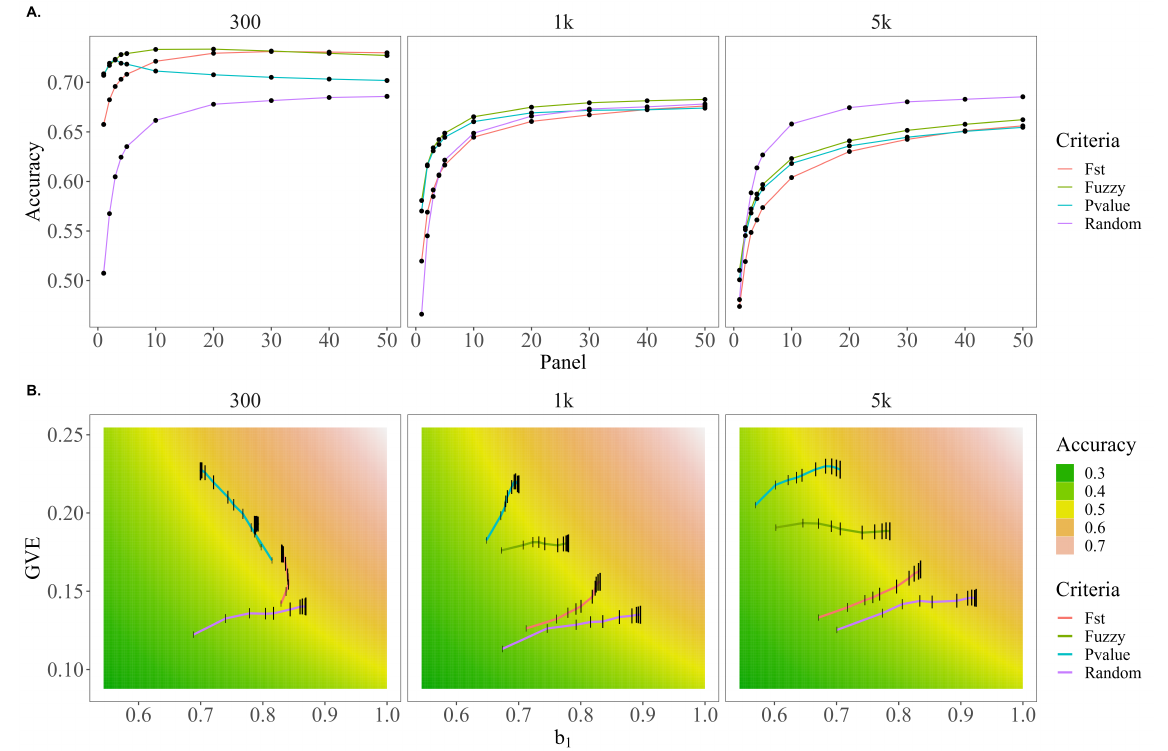
Figure 5. Trends in accuracy, dispersion, and variance of EBVs for random, F ST score, p -value, or fuzzy score preselection when all chromosomes harbor causative variants. ( A ) The trends in accuracy for random, F ST , p -value, or fuzzy score preselected panel sizes of 1–50 k SNPs. ( B ) A comparison of how the bias of EBVs ( b 1 , x -axis) and genetic variance captured by EBVs (var(ˆ u ), y -axis) for random, F ST , p -value, or fuzzy score preselected panel sizes of 1–50 k SNPs (panel size reflected by height of black bar) move through the parameter space of the genomic prediction accuracy (cor( u ,ˆ u ), gradient